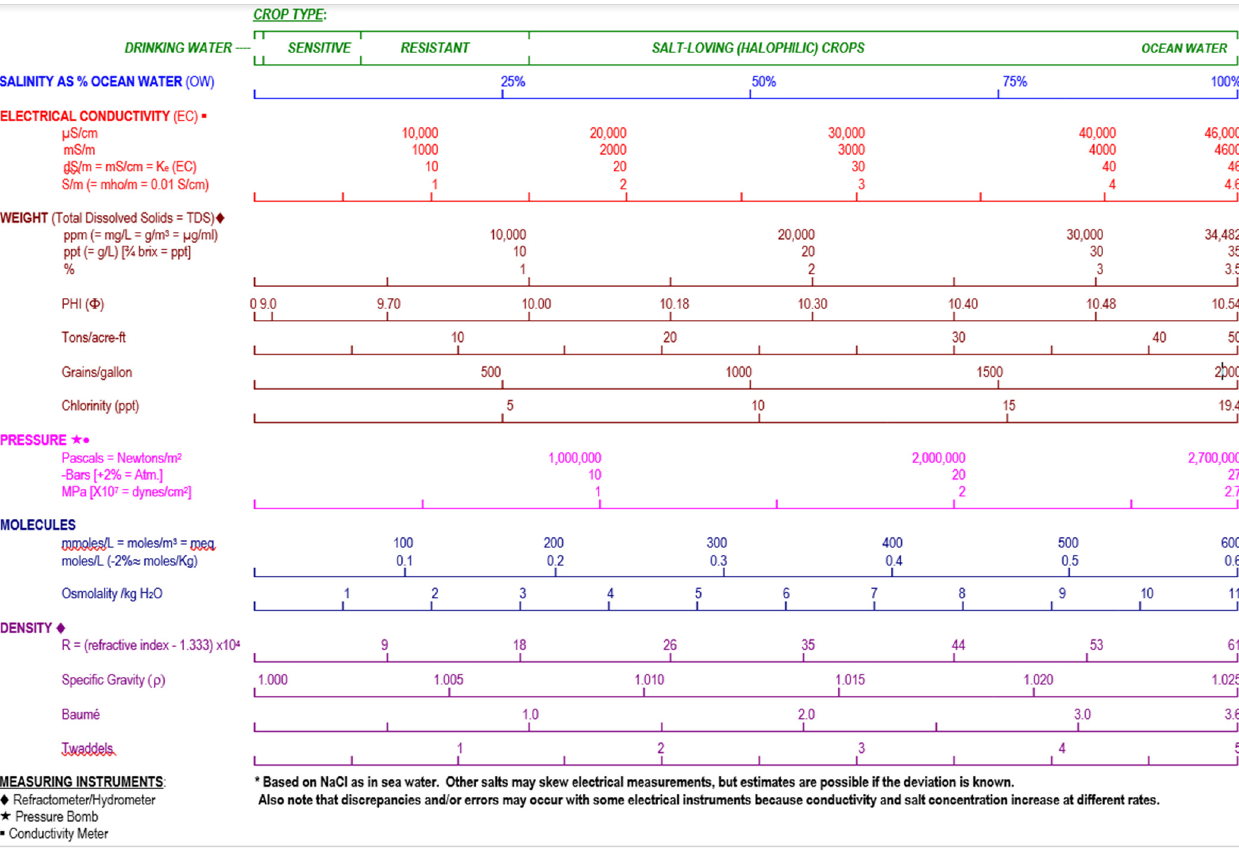
Figure 1. The Yensen scale depicting plant-soil relationships. Meq: = milli equivalents/litre; PHI: power of hydro impurities log (g salt/g water) + 12. From Nicholas P. Yensen, with permission. Halophytes have long been advocated for use as forage, fodder, oil seeds, and phar- maceuticals [27,28–30]. The use of halophytes as salad vegetables have commanded a high